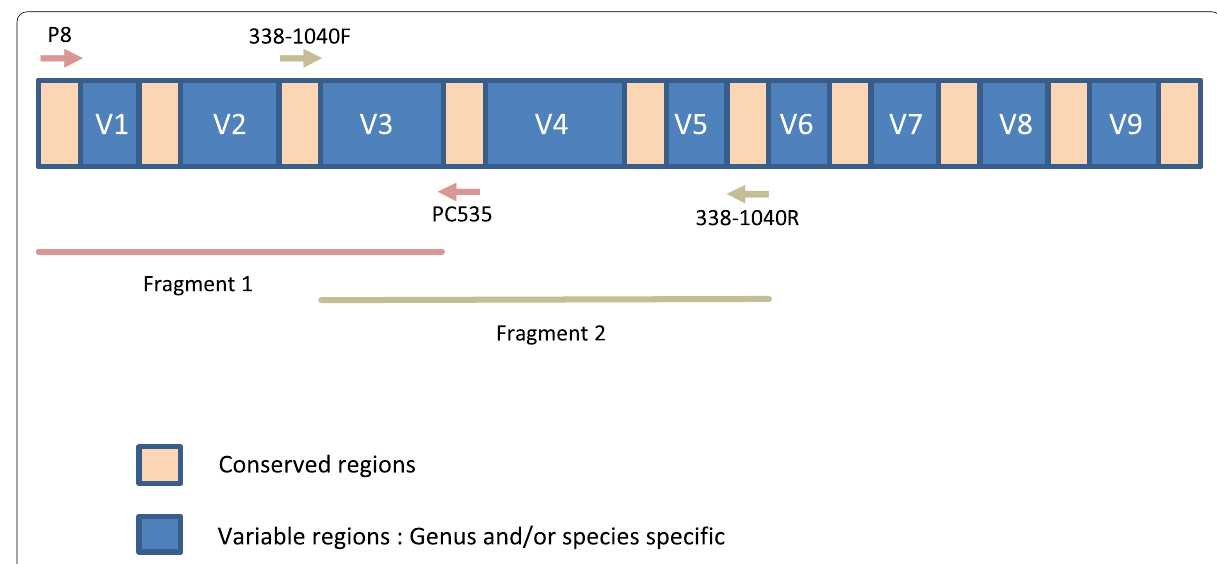
Fig. 1 Scheme of 16S rDNA portion with primer position and regions covered by amplified fragments